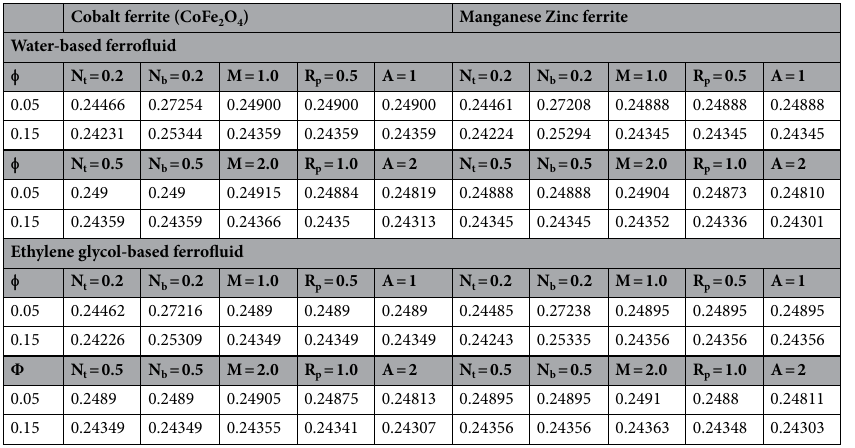
Table 3. Sherwood number of various